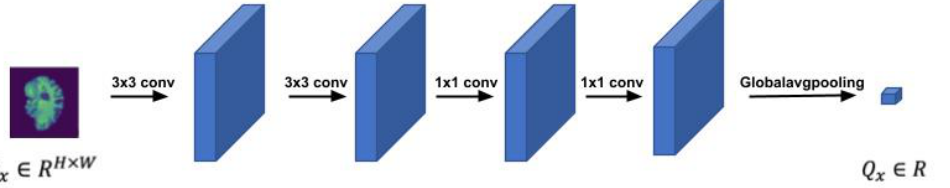
Figure 2. The structure of the slice